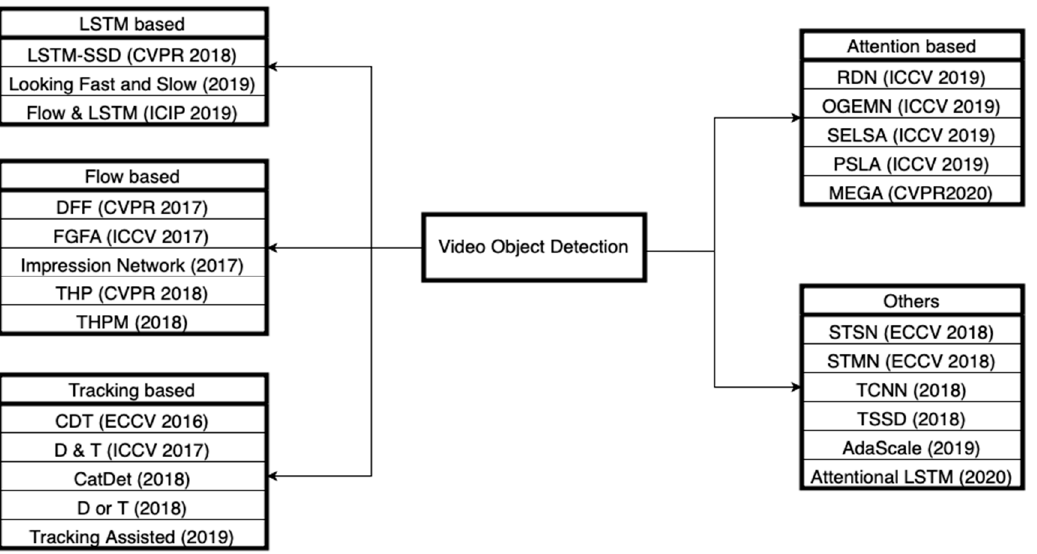
Figure 12. Video object detection methods sorted in different groups.